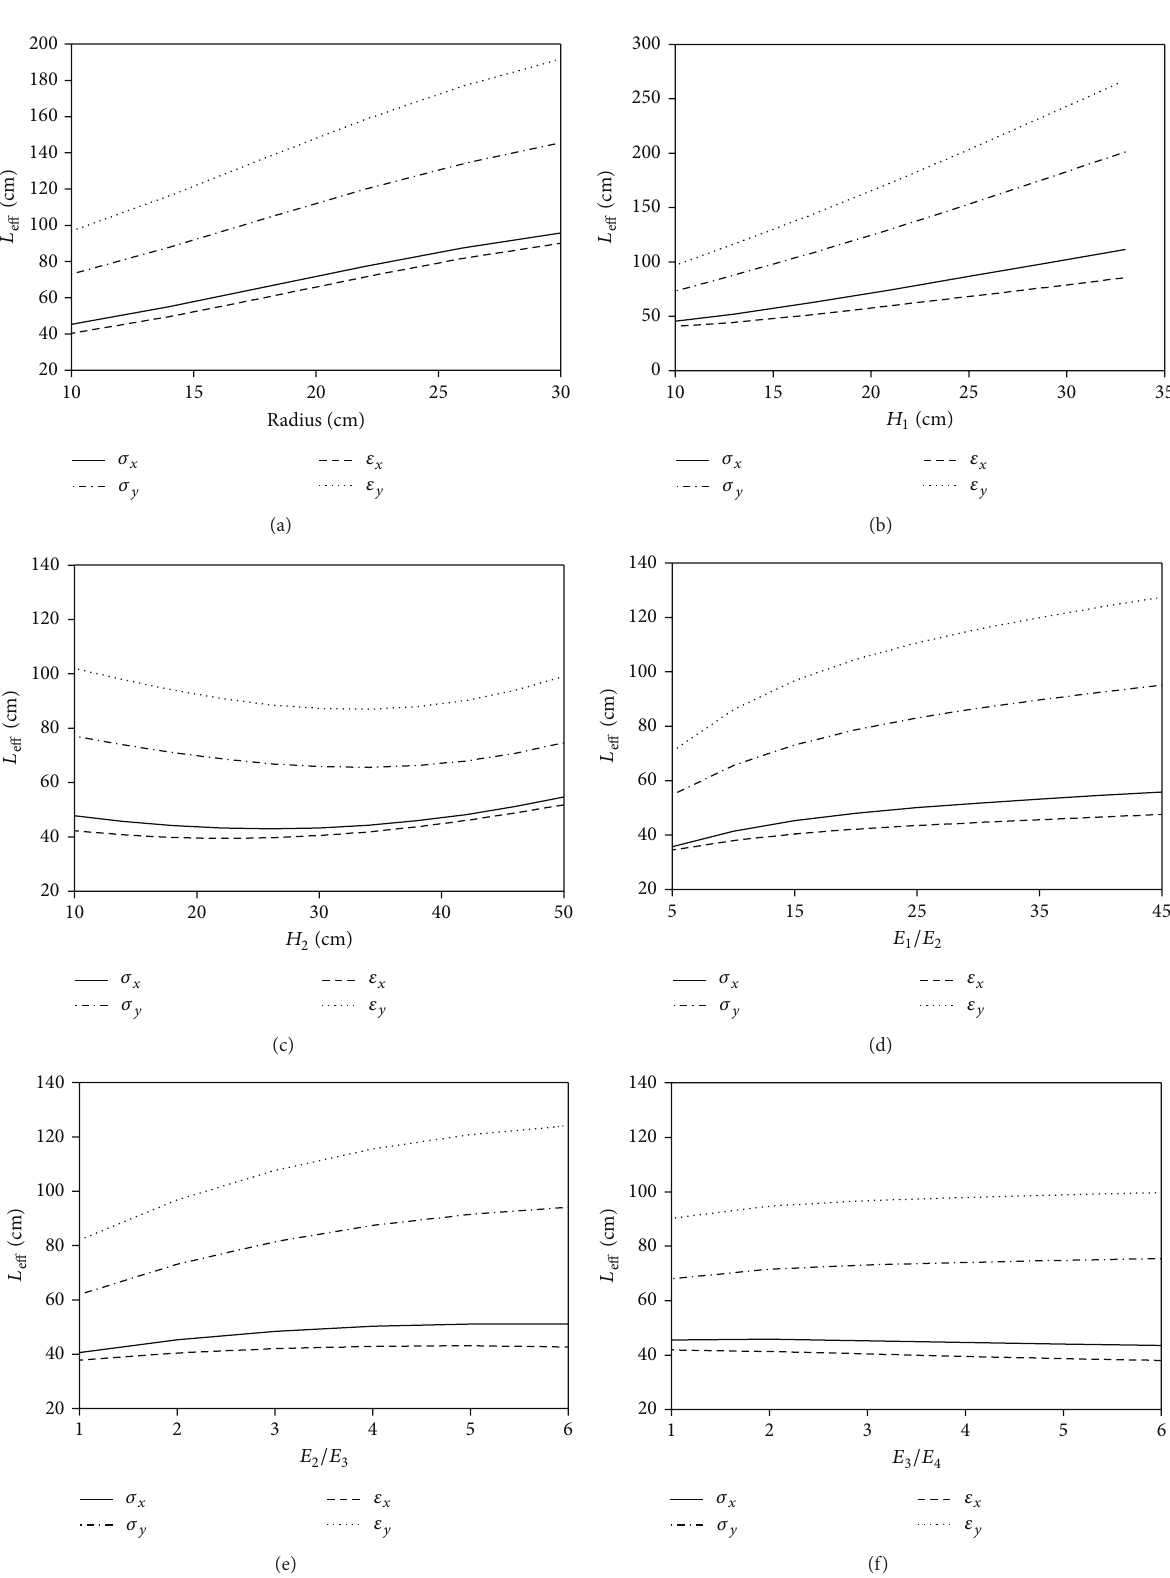
Figure 11: Effect of different parameters on effective length of tensile response